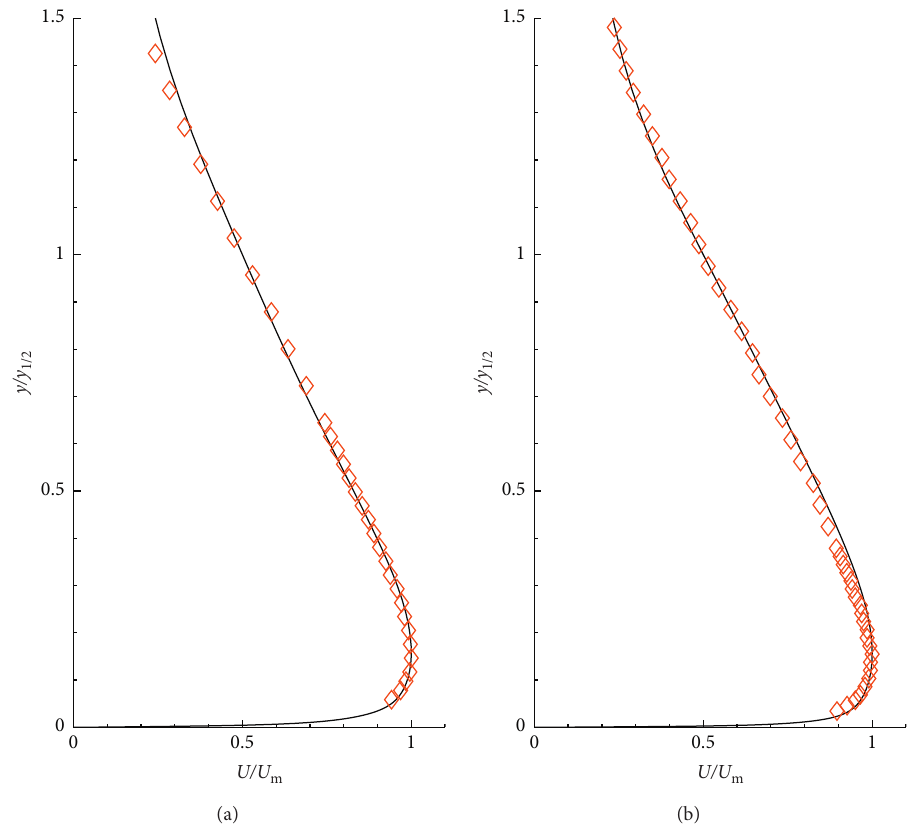
Figure 3: Comparison of mean streamwise velocity profiles, (a) x � 20 b , (b) x � 80 b : current simulation (—); McIntyre [47] ( ◇ ).